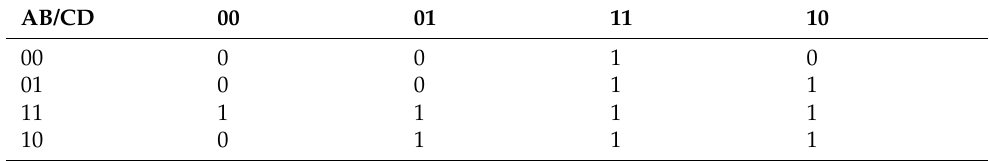
Table 6. Karnaugh map according to Table 5 for the heating